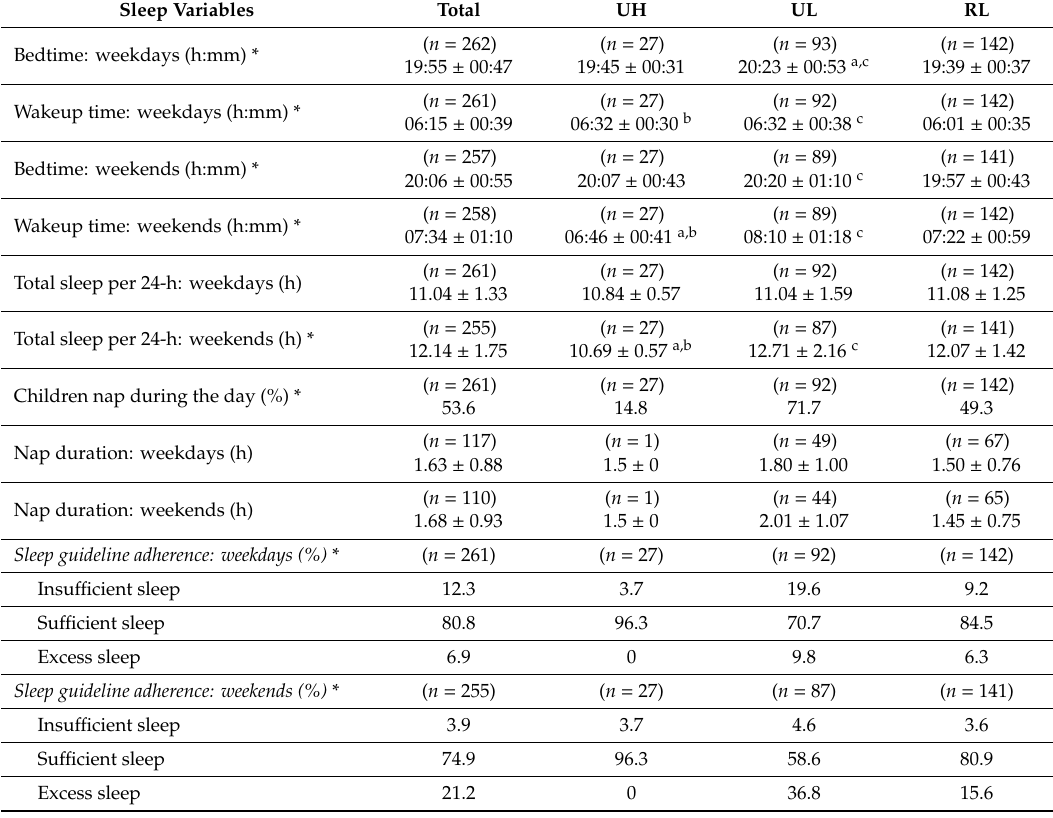
Table 4. Parent report of child sleep behaviors on weekdays and weekend days, by